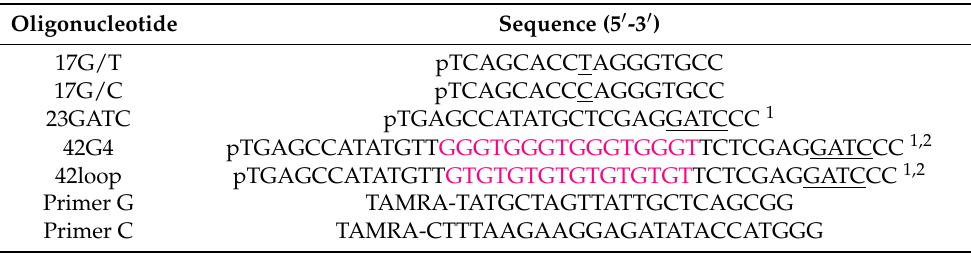
Figure 1. Construction of new type MMR models based on Dcm- and Dam-methylated pUC-MMR plasmid DNA. ( A ) Scheme of Nt.Bpu10I endonuclease-mediated double-gapped plasmid generation allowing replacement of 17- and 23-nt DNA fragments to introduce a stable parallel G4 (a schematic representation of the G4 structure is shown in pink) and monomethylated ecMutH recognition site, 5′ -GATC- 3′/3′ -Gm 6 ATC- 5′. ( B ) Overview of the assembly of the target G4-pUC plasmid and control plasmids with ecMutH recognition site and with or without G/T mismatch. Key elements of the plasmid models, including DNA mismatch, G4 structure or loop, and the ecMutH recognition site, are in bold. The Nt.Bpu10I recognition site is highlighted in green, and the oligonucleotide sequences used to replace original pUC-MMR sequences are highlighted in pink. ( C ) Monitoring the steps of G4-pUC creation by electrophoresis in 1% agarose gel prestained with ethidium bromide; the positions of open circle DNA (oc), linearized DNA (lin), covalently closed circular DNA (ccc), and gap-filling oligonucleotides (oligo) are indicated on the right. Marker DNA length (in kb) is shown on the left. The numbers denoting the steps of obtaining modified plasmids (from 1 to 6 ) at the top of panels ( A , C ) match. Table 1. Primary structures of the oligonucleotides used to construct DNA plasmids and primers for the Taq polymerase stalling